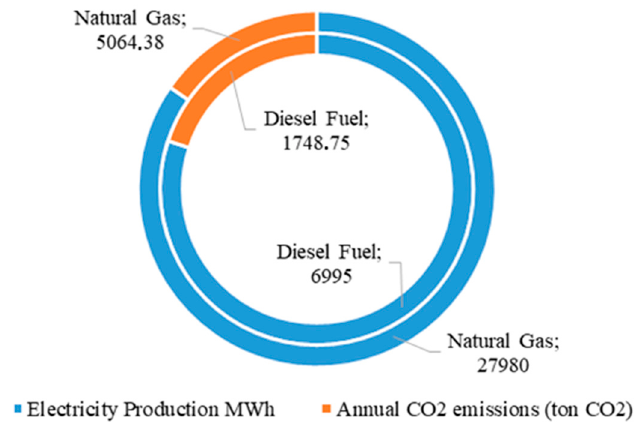
Figure 8. Annual CO 2 emissions for 34.976 MWh electricity generation (Diesel: inner ring, Natural Gas: outer ring).